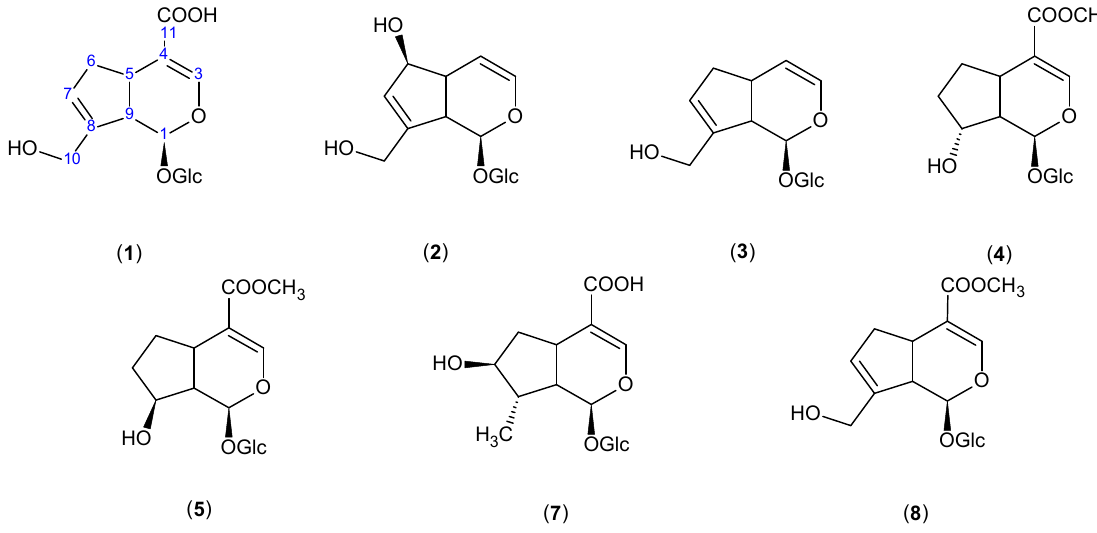
Figure 4. Chemical structures of the compounds evaluated on TPA-induced mouse ear